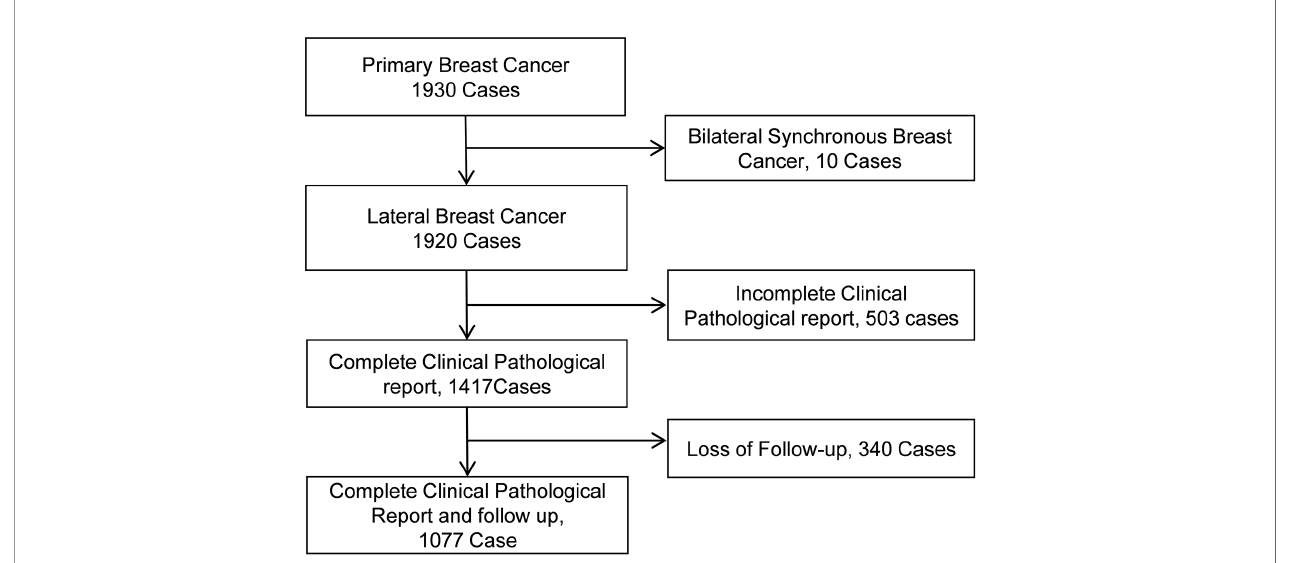
FIGURE 1 | Flow of participants.